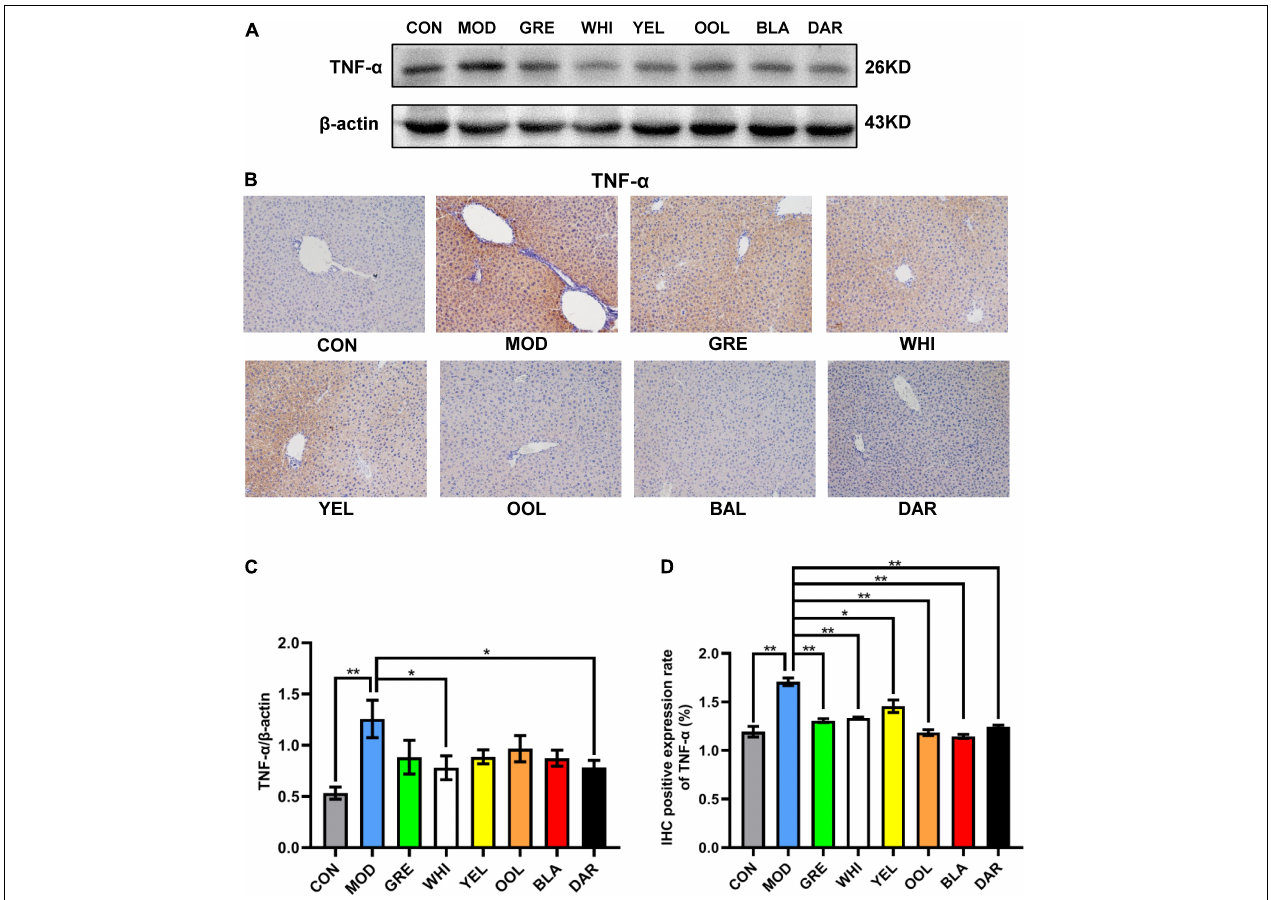
FIGURE 7 | Effects of WEATs on TNF- α expression in the liver of mice. Representative immunoblots (A) and IHC images (B) of TNF- α expression in the liver. Quantification of TNF- α expression by western blotting (C) and IHC (D) . Each value represents the mean ± SEM ( n = 10). * p < 0.05 vs. MOD; ** p < 0.01 vs. MOD.